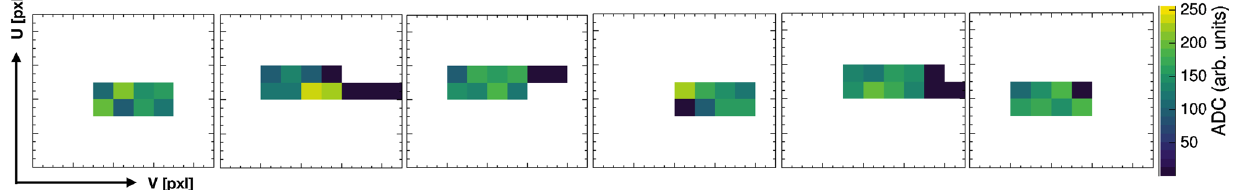
Fig. 16 Example magnetic-monopole matrices with a high AE and a comparably low MLP classficiation